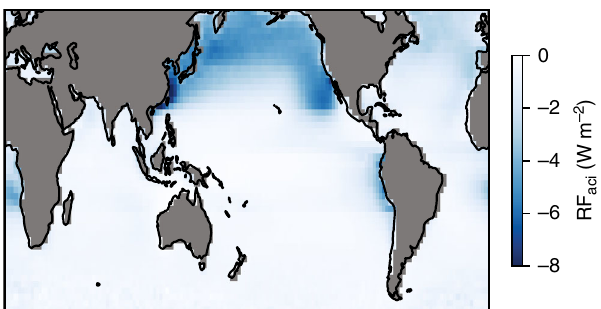
Fig. 5 Spatial distribution of radiative forcing over ocean. Spatial distribution of the radiative forcing due to aerosol – cloud interactions over the ocean (RF ), based on the mean of the different model estimates for the aci ; ocean increase in cloud condensation nuclei (CCN) column number between present day (PD) and pre-industrial (PI) times.